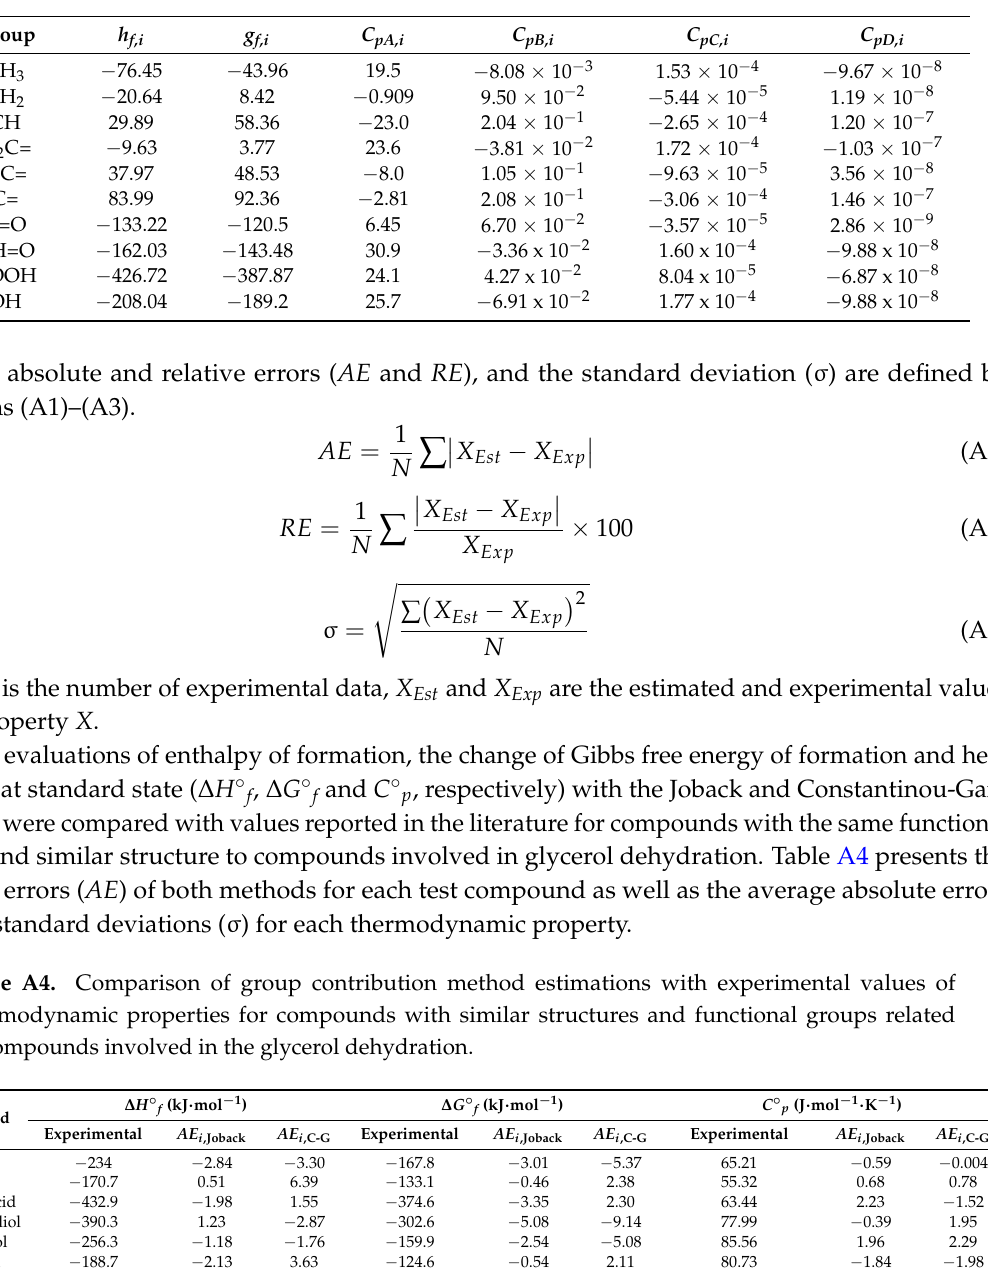
Table A3. Group contributions of the Joback method [82].